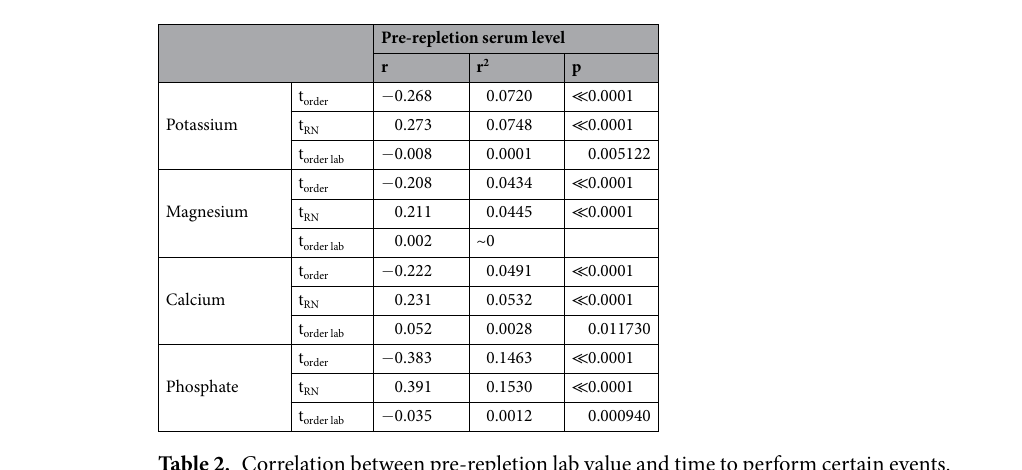
for timeliness (Table 2), the pre-repletion serum level for all electrolytes had a weak negative correlation with time to place the order (t order ), a weak positive correlation with execution of the order by a nurse (t RN ), and a correlation close to zero when the order was placed for follow up labs (t order lab ).